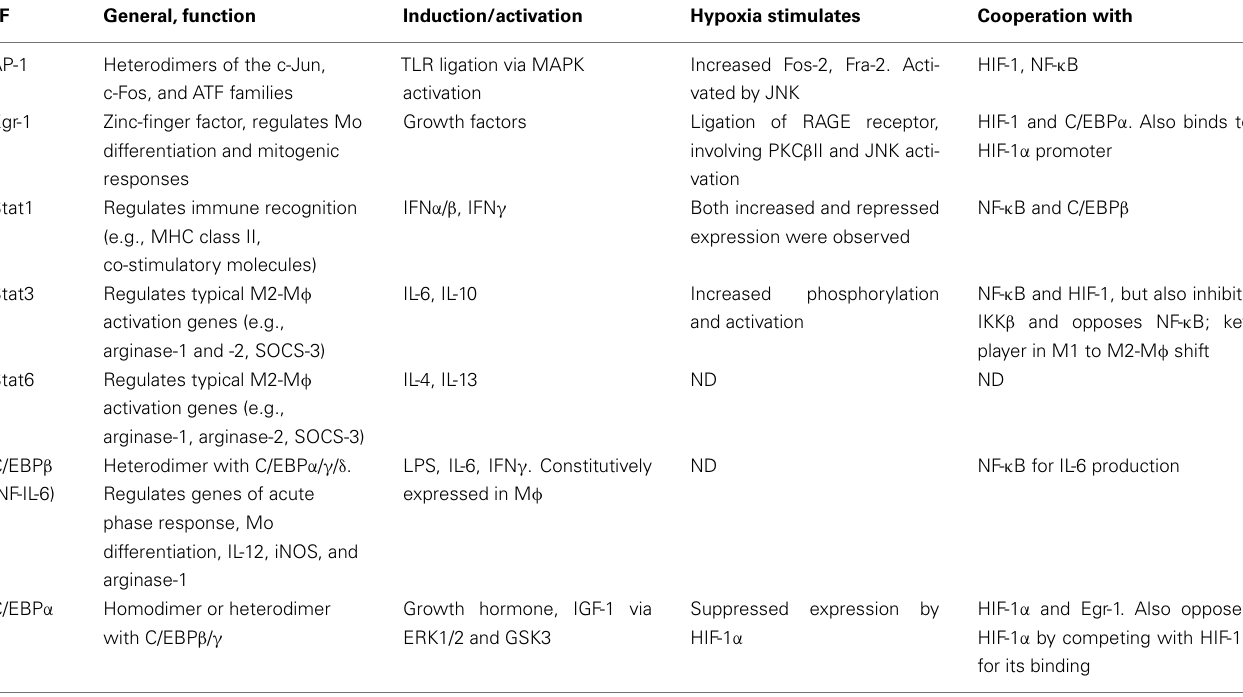
Table 1 |Transcription factors other than HIFs and NF- κ B, which are involved in hypoxic regulation of gene